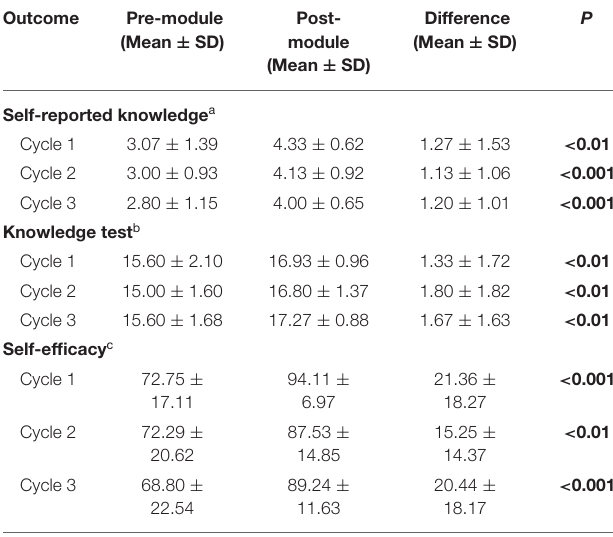
TABLE 3 | Differences in knowledge of and self-efficacy to engage in patient-oriented research before and after completing Research 101.